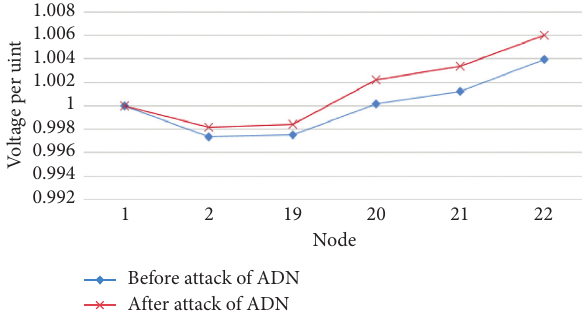
Figure 11: The partial node voltage before and after A II